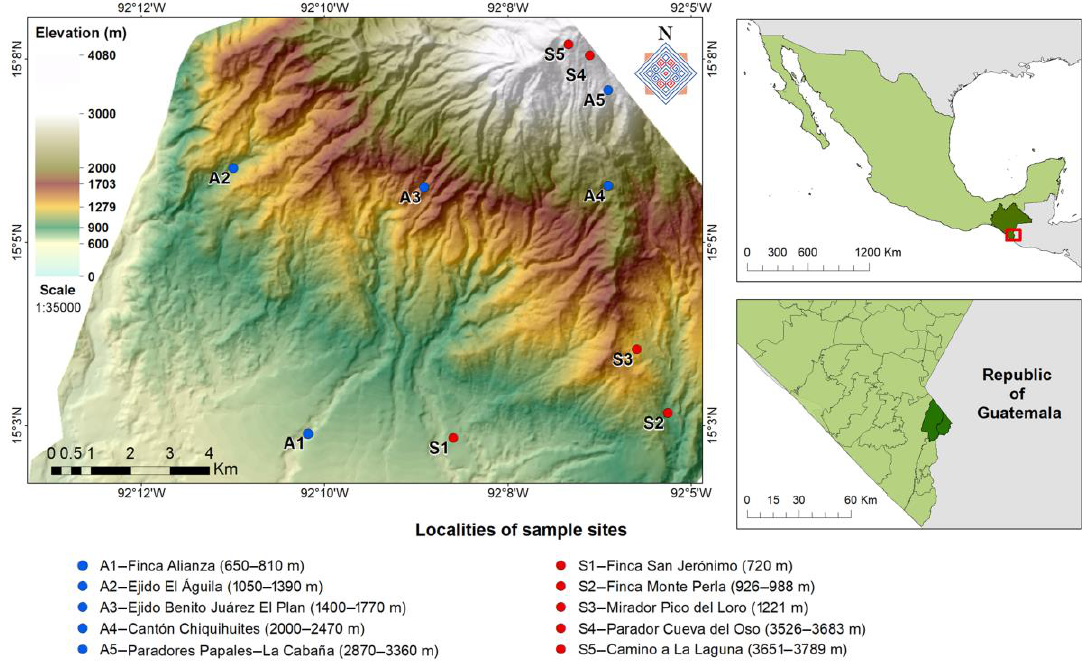
Figure 3. Map with the sampling sites at the Tacan á volcano Biosphere Reserve (Chiapas, Mexico). A1–A5: Annual systematic sampling sites; S1–S5: Sporadic sampling sites. Design of the wind rose was based on the Mayan symbol “the Four Sides of the Earth (Xocom Balumil)”; the rhombuses on the vertical axis joined to the central rhombus mean east and west, while the extreme lateral rhombuses represent the north and south [redrawn from